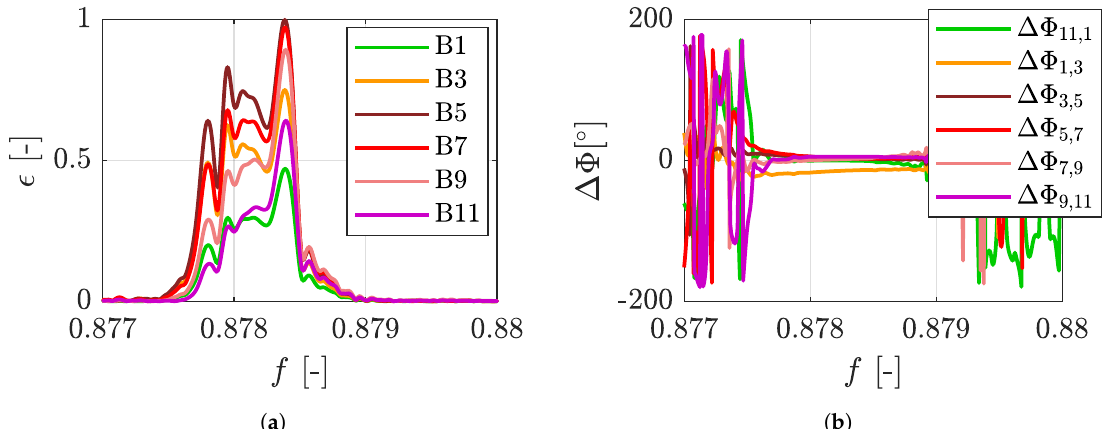
Figure 7. Vibratory Mode 8-2: Frequency domain and phase lag. ( a ) Normalized amplitude of all SG-applied blades during resonance M8-2; ( b ) Phase lag of all SG-applied blades during resonance M8-2 in the frequency domain.